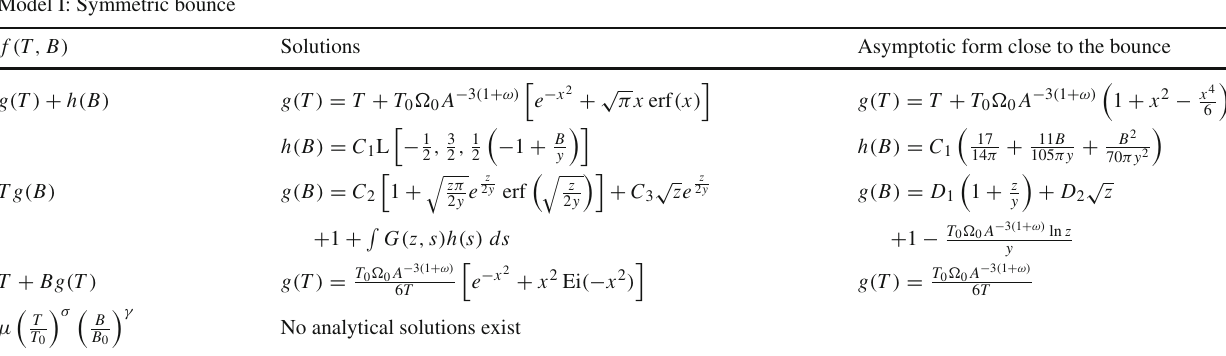
Table1 AsummaryofthereconstructedLagrangiansolutionstogether with the associated asymptotic forms close to the bounce in the case of the symmetric bounce cosmology. The parameters x 2 := 3 T ( 1 + ω) y := 12 α , and z := B − y have been defined in order to sim- t 2 ∗